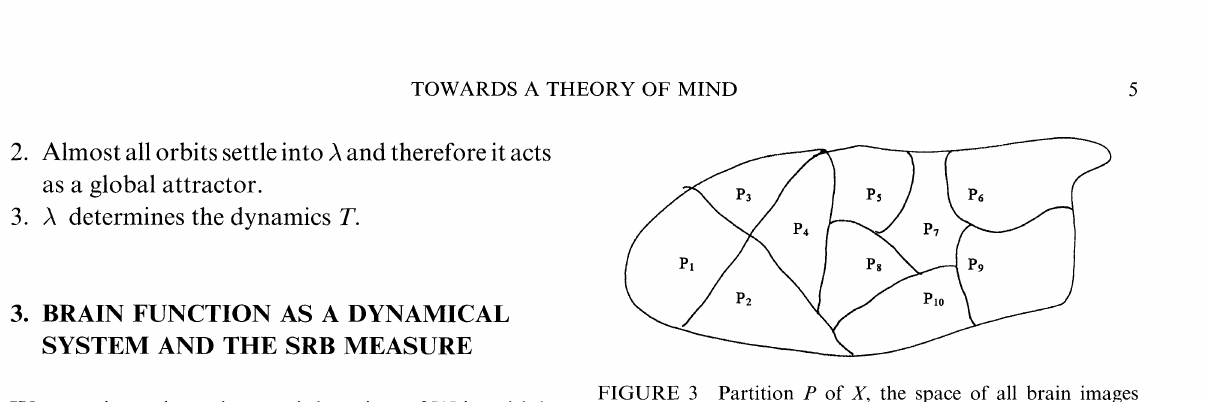
FIGURE 3 Partition P of X, the space of all brain images relevant to